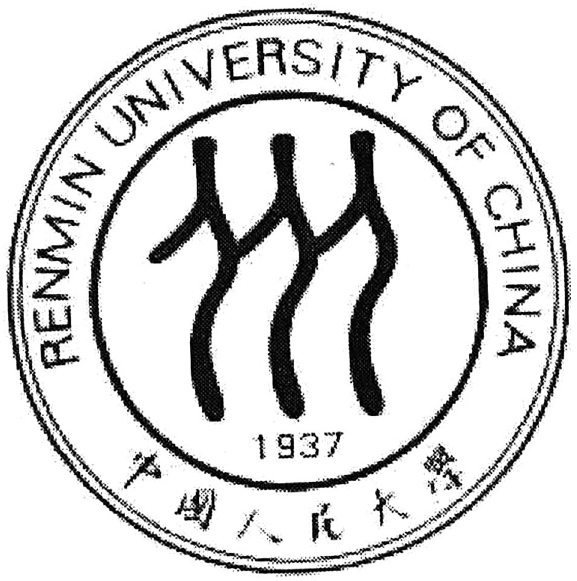
Fig. 4 Seal trademark of Renmin University of China. Application/